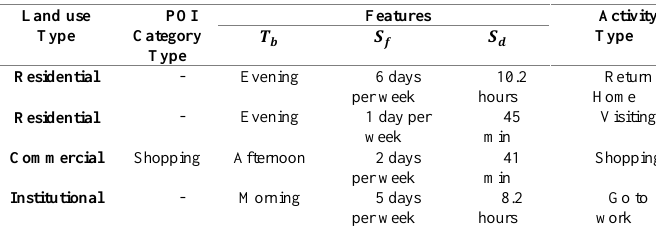
Table 9. Some inferred activity types.